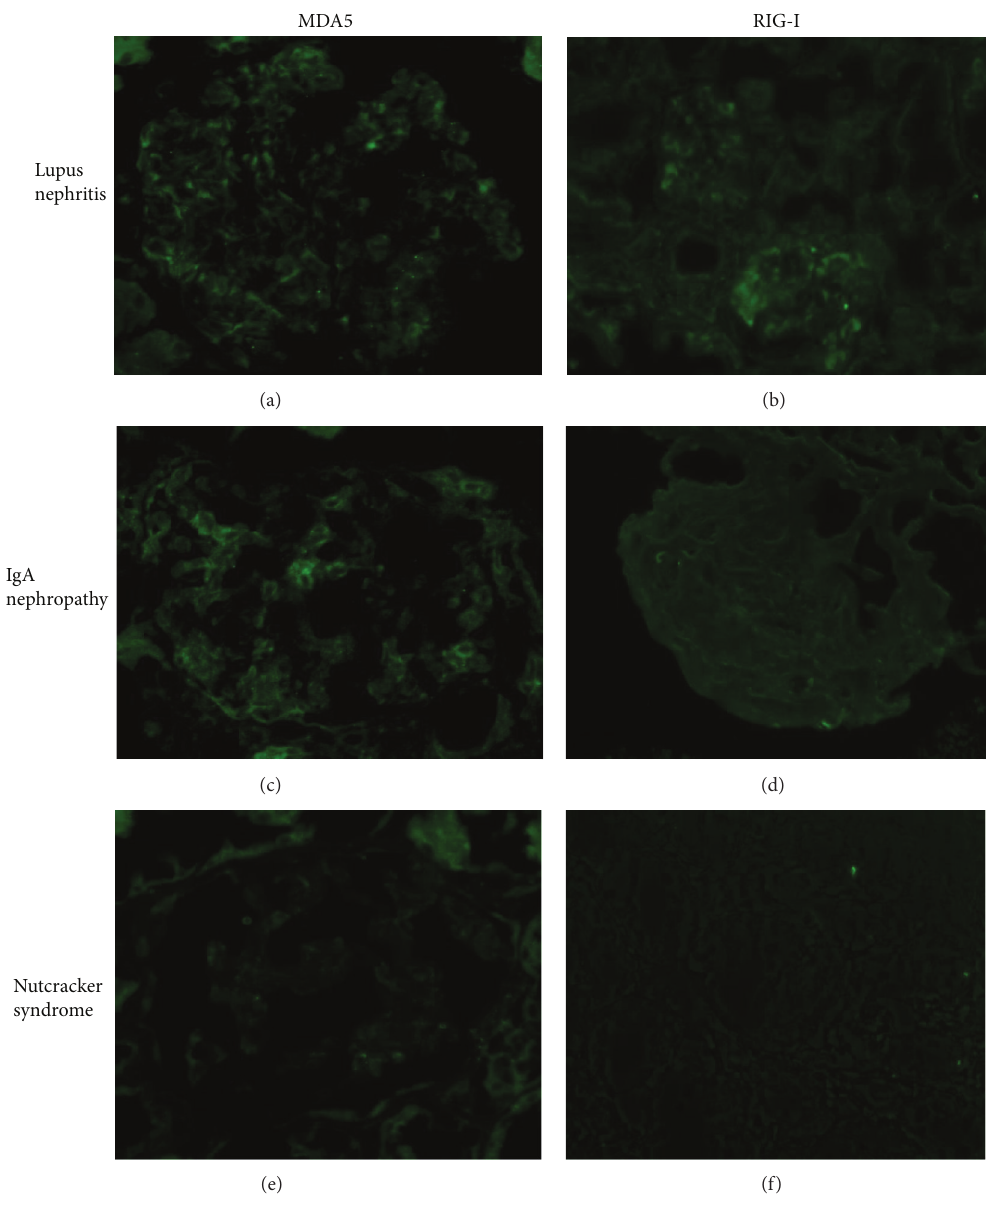
Figure 2: Immunoreactivity of MDA5 and RIG-I in biopsy specimens (Imaizumi et al. Tohoku J Exp Med 2012). Stored kidney specimens in good condition obtained from cases of diffuse proliferative lupus nephritis, proteinuric IgA nephropathy, minimal change nephrotic syndrome, and nutcracker syndrome were used for immunofluorescent study of MDA5 and RIG-I expression. After blocking by incubation with 1% goat serum, the slides were incubated with an anti-MDA5 antibody (1:100) or an anti-RIG-I antibody (1:1000). Intense MDA5 immunoreactivity was detected in MCs of the specimens from diffuse proliferative lupus nephritis and proteinuric IgA nephropathy, while the expression in nonimmune complex-mediated renal diseases was undetectable. Interestingly, RIG-I immunoreactivity was only in diffuse proliferative lupus